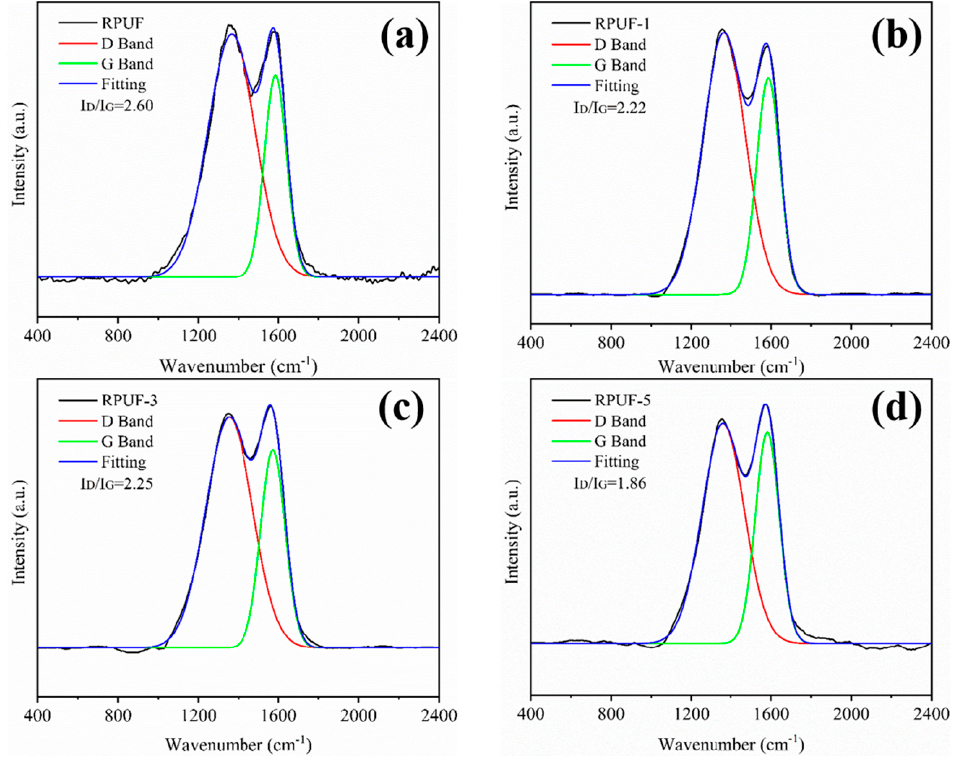
Figure 8. Raman spectra of RPUF and RPUF-R composites: ( a ) RPUF; ( b ) RPUF-1; ( c ) RPUF-3; ( d )